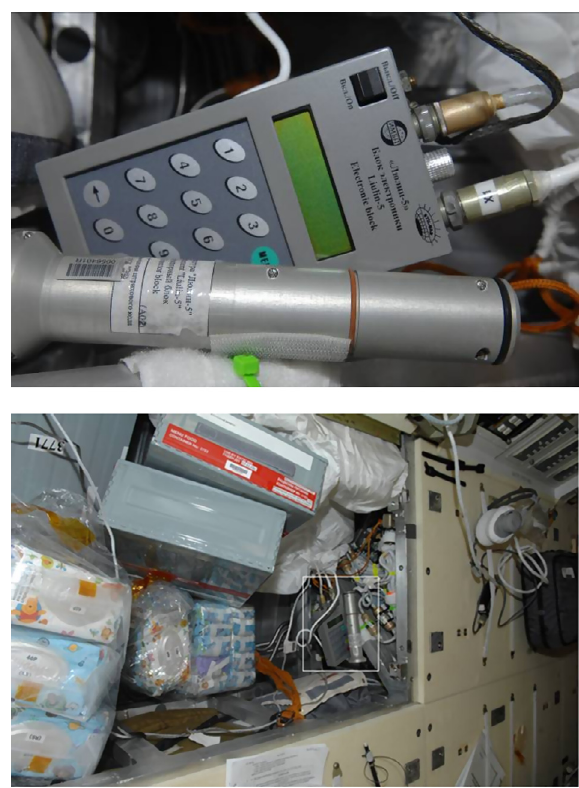
Fig. 1. Upper panel – the Liulin-5 detector module (front) and electronic module (back). Bottom panel – Liulin-5 (marked in the white rectangle) located behind panel 205 in the MIM1 module of